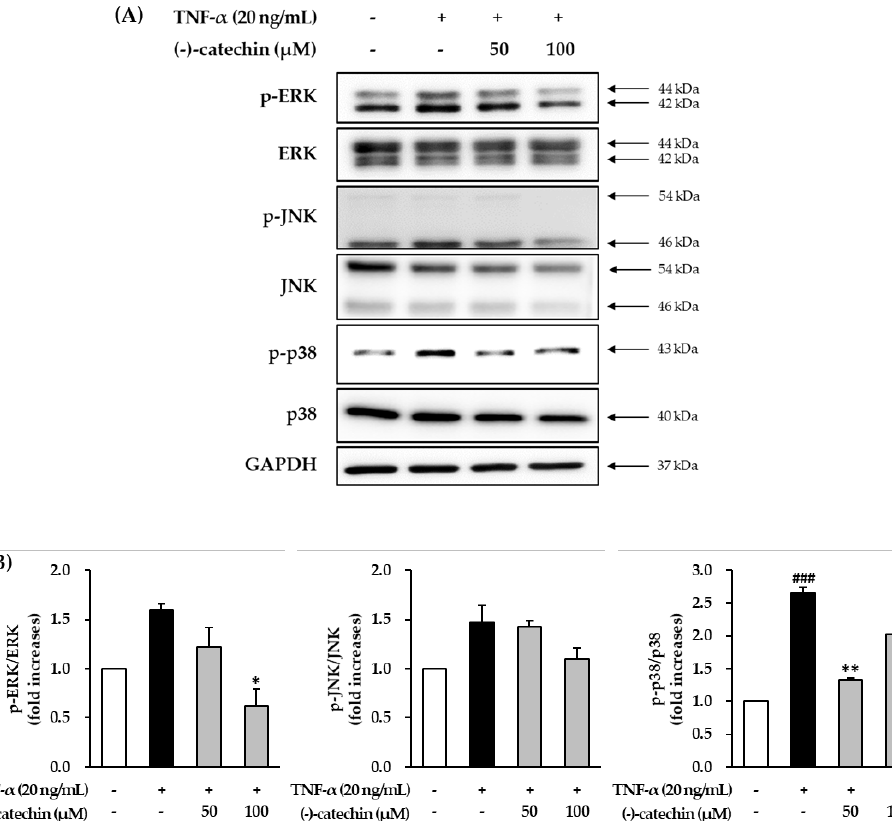
Figure 4. E ff ect of (-)-catechin on tumor necrosis factor- α (TNF- α )-induced phosphorylation of mitogen-activated protein kinases (MAPKs) in normal human dermal fibroblasts (NHDFs). ( A ) The cells were treated with 50 and 100 µ M (-)-catechin for 1 h, and then with 20 ng / mL TNF- α for 15 min. The immunoreactive bands were analyzed by immunoblotting of p-JNK, JNK, p-ERK, ERK, p-p38, p38, and GAPDH. ( B ) The graphs present the fold-increase in the phosphorylation of MAPKs compared with the untreated group. The data are presented as mean ± SEM (N = 3). ### p < 0.001 compared with the untreated group; * p < 0.05 and ** p < 0.01 compared with the TNF- α -treated group.